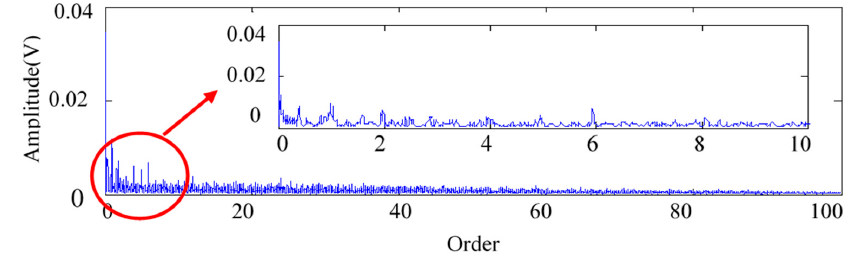
Figure 7. The time domain waveform of the collected original signal.